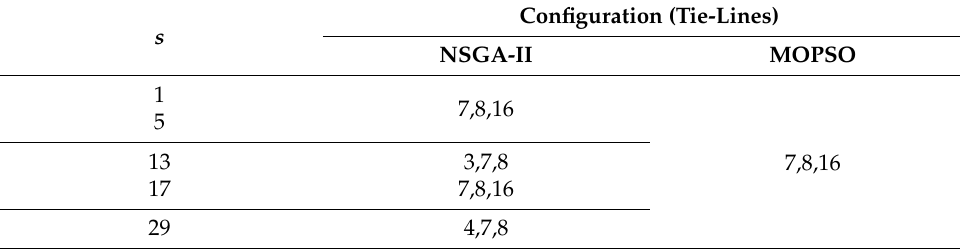
Table 8. The 16-node distribution network configurations at multiple